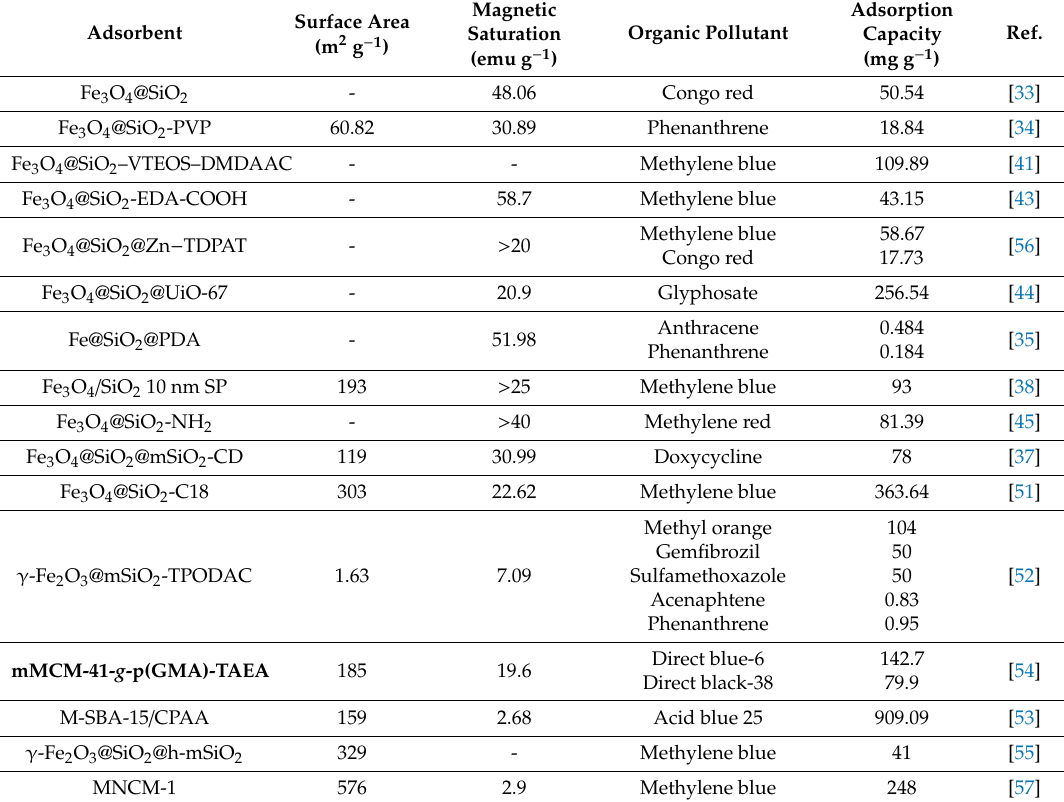
Table 1. Application of magnetic silica-based nanoadsorbents for organic pollutants removal from water.